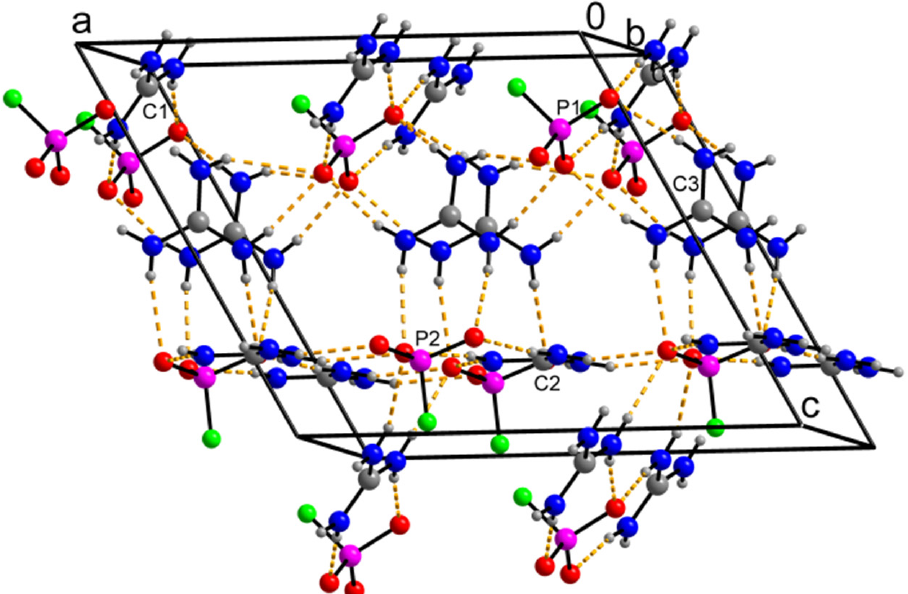
Figure 4. View of the unit cell of bis(guanidinium) trioxofluorophosphate—compound ( I ). The other title structures are virtually the same. Applied colours: C—grey, N—blue, O—red, H—grey, P—violet, F—green. The Figure was prepared by [18].